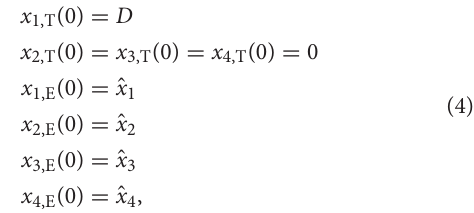
FIGURE 2 | (A) Spaghetti plot of the proportion of administered IgG remaining in plasma (blue) and the body (red) in six subjects; data from Waldmann and Strober (21), Solomon et al. (18), and Waldmann and Terry (23). (B) Plasma concentration dependence of the fractional catabolic rate (FCR); redrawn from Waldmann and Strober (21), with permission from S. Karger AG,